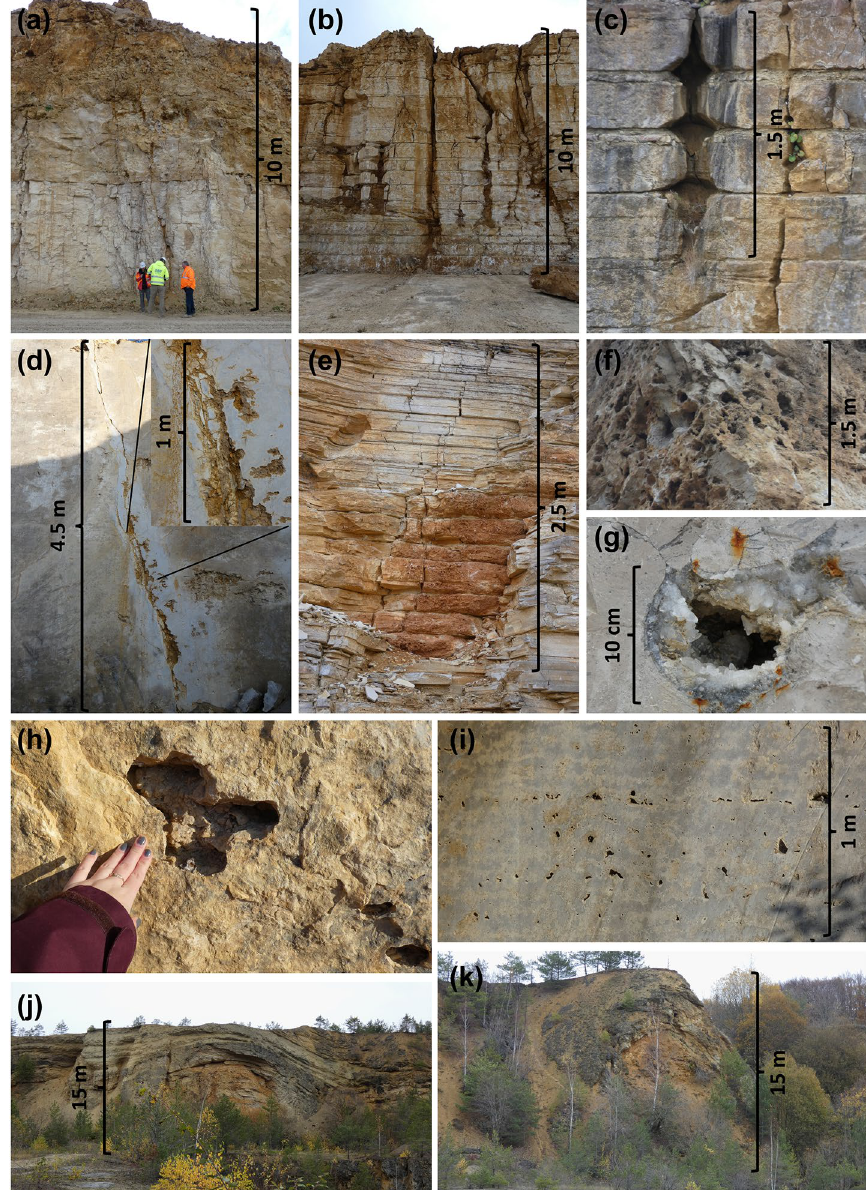
Fig. 14 Outcrop photos of the Jurassic carbonates from the Franconian Alb ( a ) showing dissolution along fractures ( b – e ), intense karstification of massive facies ( f – h ) and along bedding planes ( i ), with cavities partly cemented by calcite ( g ), and reef buildups ( j , k ). Karst and fractures are the most important controlling factors of the reservoir quality in the research area, but the irregular distribution of karstified and fractured zones makes it necessary to analyse it in 3D using, e.g., seismic